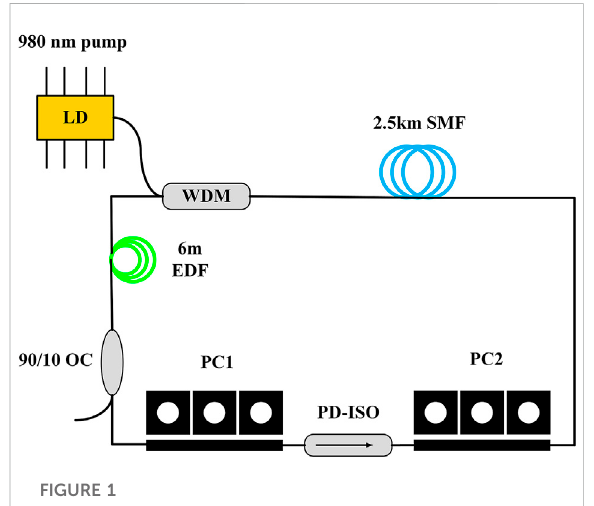
FIGURE 1 Schematic diagram of the MLFL based on NPR